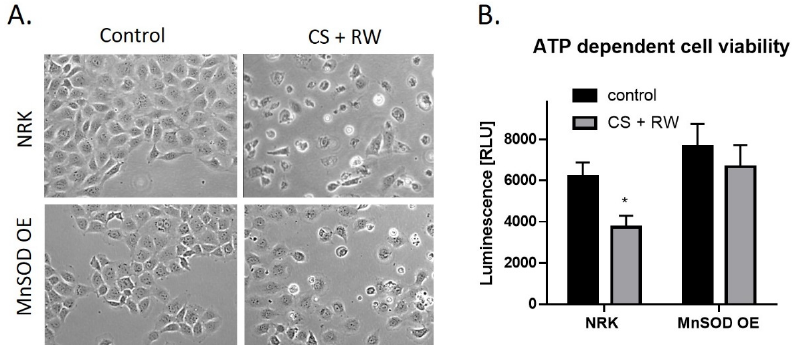
Figure 6. MnSOD overexpression attenuates CS + RW-induced cell death. ( A ) Microscopic evaluation for qualitative assessment of cell death. ( B ) ATP-dependent cell viability assay shows that overexpression of MnSOD protects against CS + RW induced loss of cell viability. Unpaired t-test was used to assess differences between conditions. Values are expressed as ±SEM ( n = 5). * p <